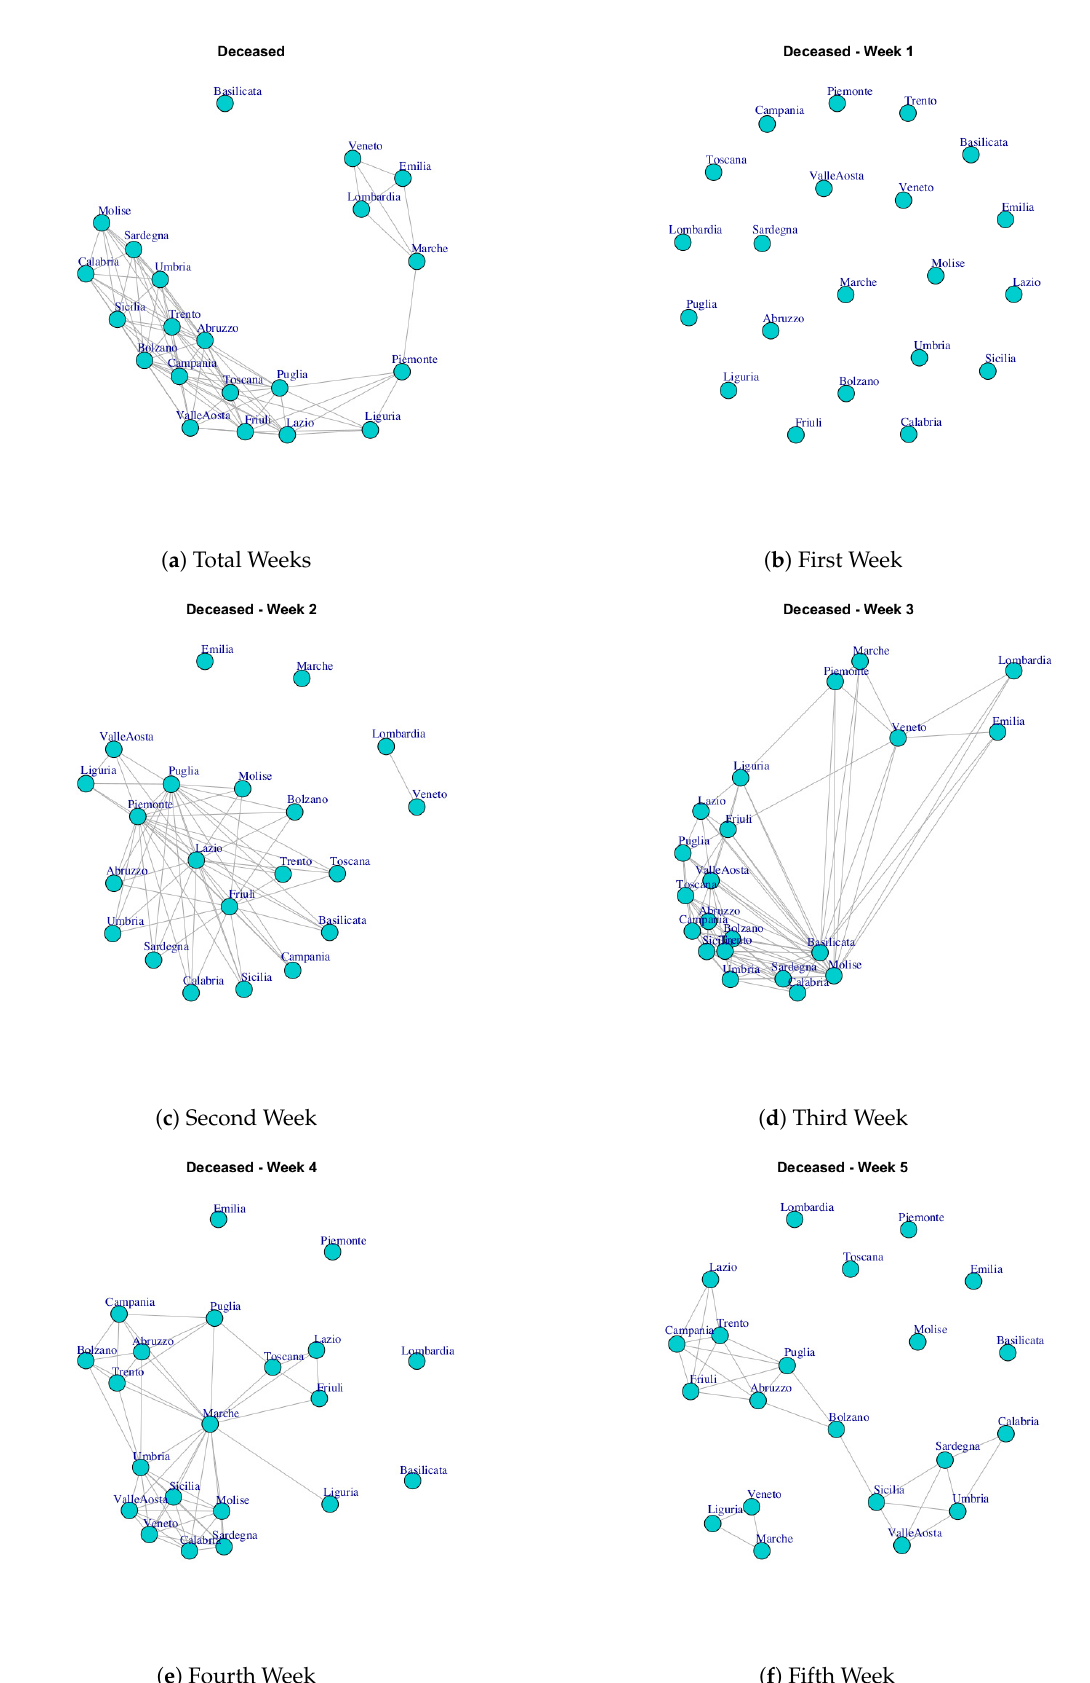
Figure 10. Evolution of Deceased